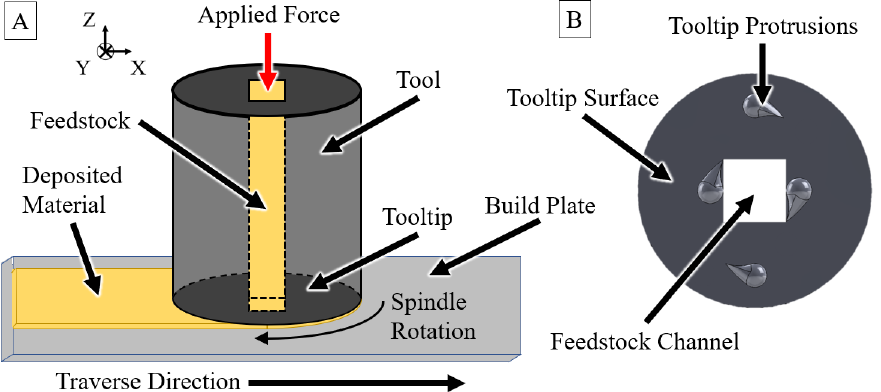
Figure 1. ( A ) The AFSD process. ( B ) The AFSD tool-shoulder